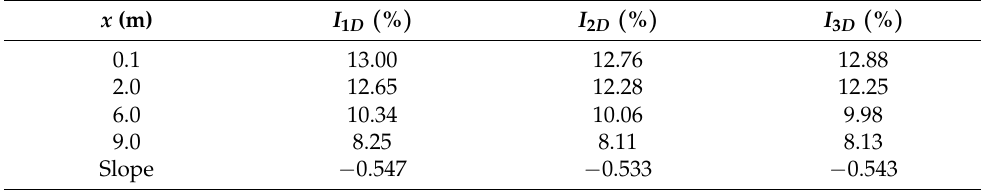
= 0.01638 m 2 .s − 2 and ∆ x = 0.035 m. i